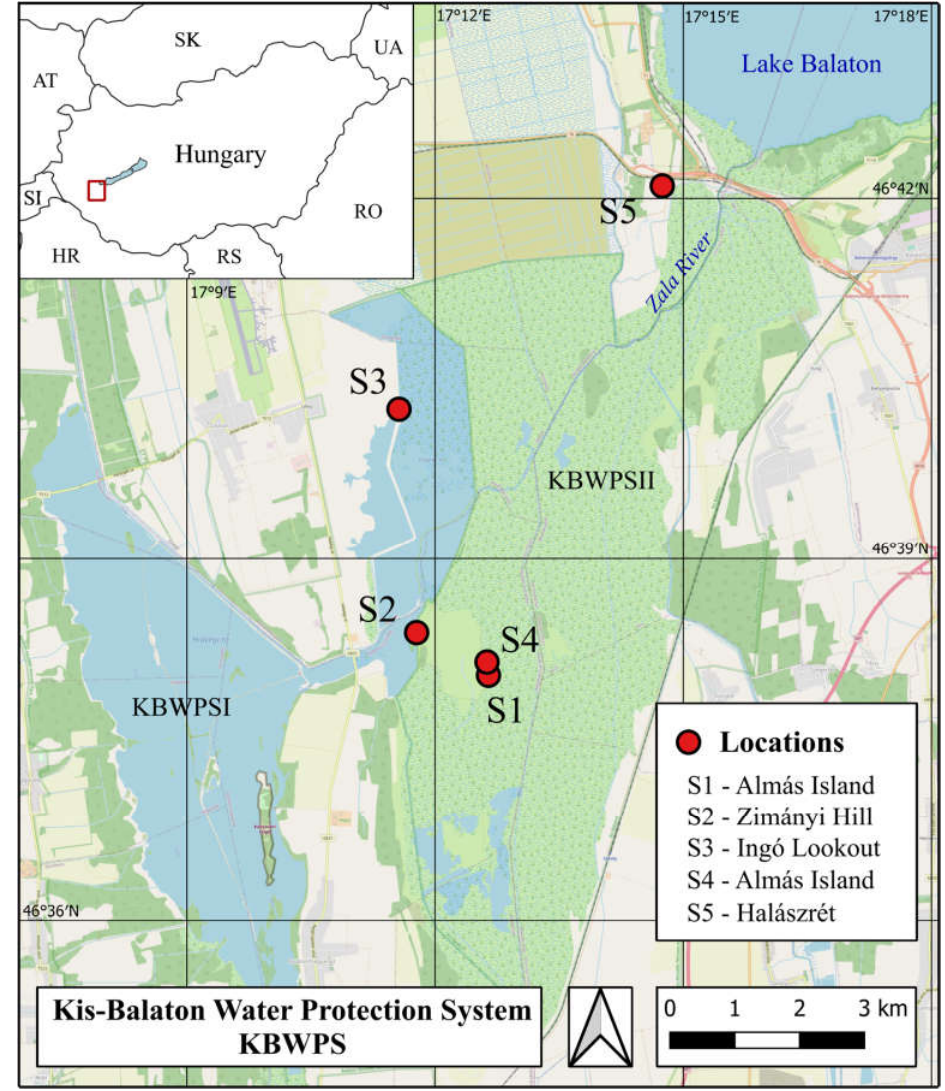
Figure 1. The location of Kis-Balaton and the egg-laying sites of the European pond turtle where the nest predation study was conducted (Site 1–3) and the other two sites where the effects of the treatments on predation were examined (Site 4–5).